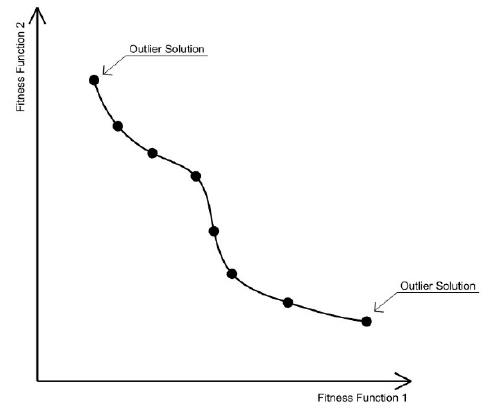
Figure 3. Example of the fittest solutions (or ‘outliers’) for each fitness function.